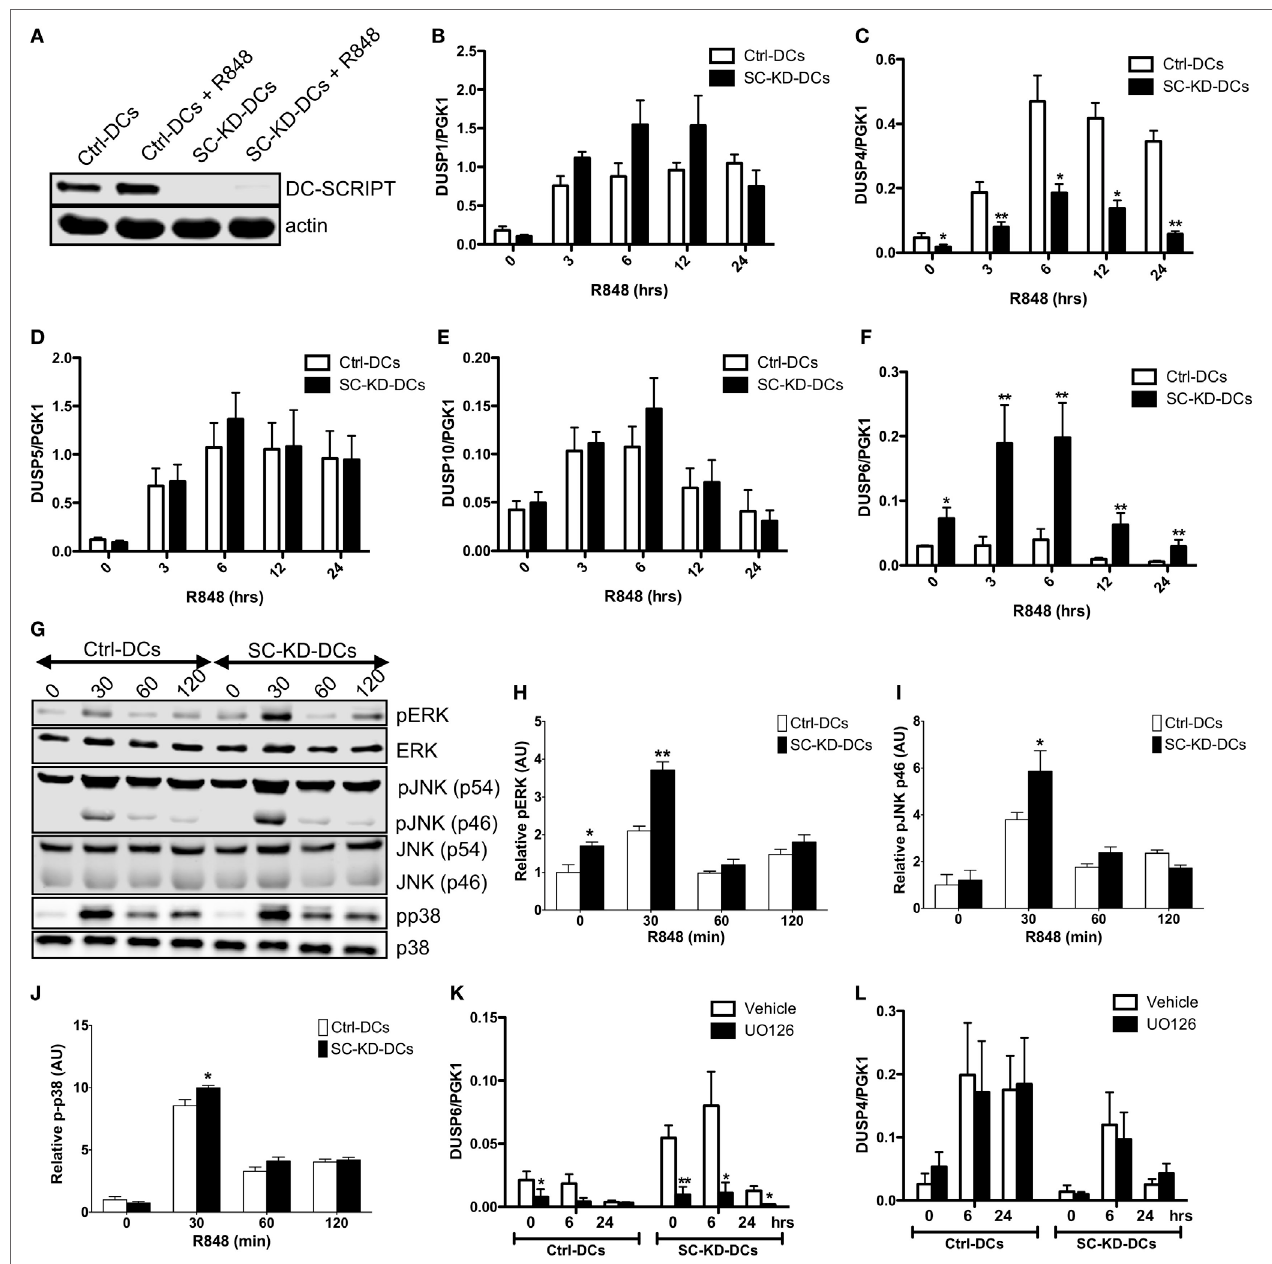
FigUre 2 | DC-SCRIPT affects the MAPK pathway. (a) Representative western blot of siRNA-mediated DC-SCRIPT knockdown in immature and R848-stimulated dendritic cells (DCs). (B–F) R848-stimulated Ctrl-DC and SC-KD-DC time course for dual-specificity phosphatase (DUSP)1, 4, 5, 6, and 10 ( n = 4, mean + SEM). (g–J) Phosphorylation and total protein expression of ERK, JNK, and p38 in Ctrl-DCs and SC-KD-DCs after stimulation with R848 ( n = 5, mean + SEM). (K,l) DUSP6 and DUSP4 expression in Ctrl-DCs and SC-KD-DCs pretreated with UO126 (MEK inhibitor) or vehicle control for 1 h, followed by R848 stimulation ( n = 4, mean + SEM). Statistics: Student’s paired t test, Ctrl-DCs were compared to SC-KD-DCs at the same time point. * p < 0.05, ** p < 0.01. See also Figure S2 in Supplementary